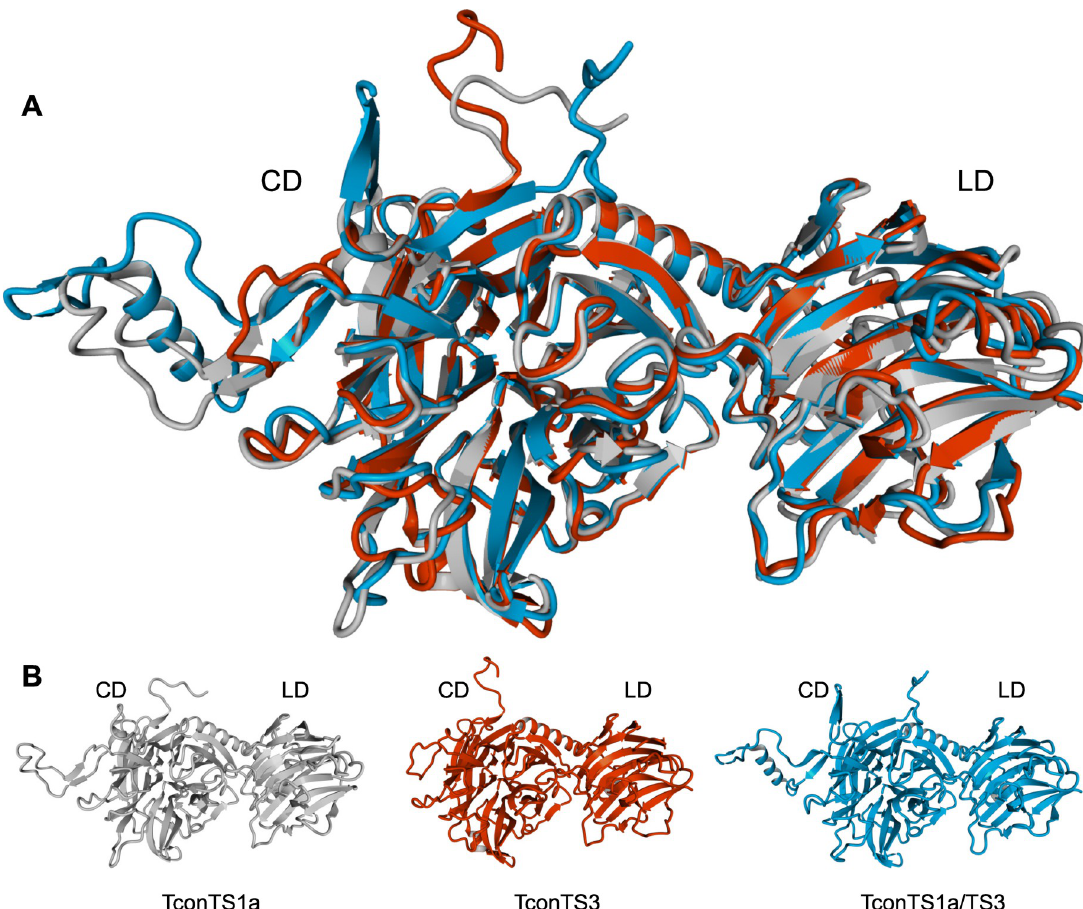
Fig 2. Homology model of domain swapped TconTS1a/TS3. A: Structural alignment of TconTS1a, TconTS3 and domain swapped TconTS1a/TS3 homology model. B: Homology model of TconTS1a (grey), TconTS3 (red) and TconTS1a/TS3 (blue). Catalytic domain (CD) and lectin-like domain (LD) are indicated. Homology models and structure alignment were generated using the YASARA Structure module as described under Methods.